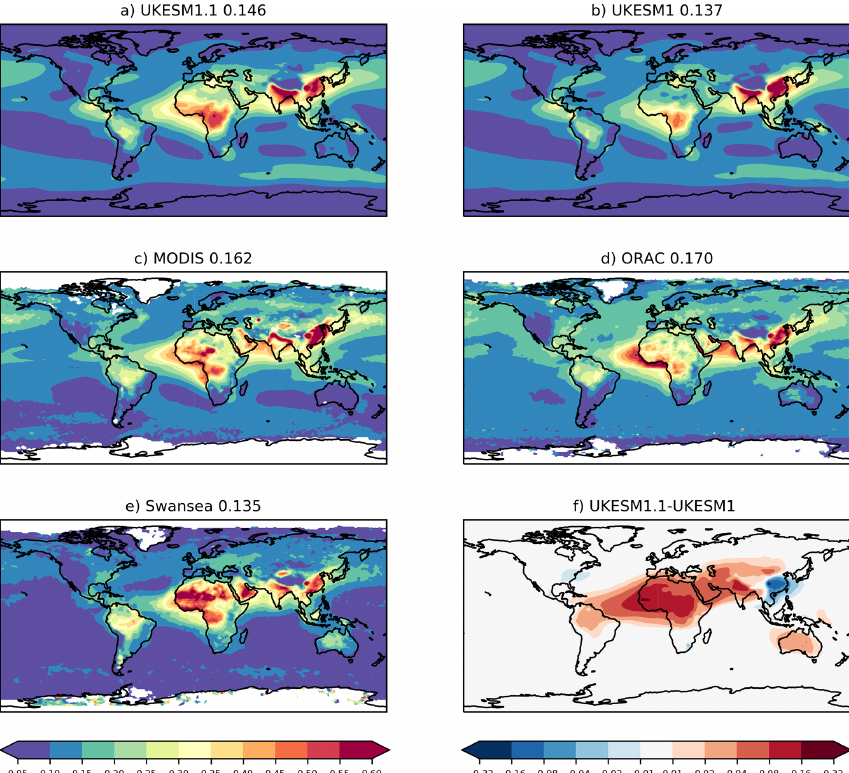
Figure 8. Annual mean AOD at 550nm from (a) UKESM1.1. (b) UKESM1 simulations over the 2003–2014 period. Satellite-derived AOD over the same period from (c) MODIS c6 (Hsu et al., 2004), (d) ORAC (Optimal Retrieval of Aerosol and Cloud; Thomas et al., 2009) and (e) Swansea retrieval algorithms (Bevan et al., 2012). (f) UKESM1.1 − UKESM1 AOD difference. The global mean AOD from models and satellites are shown in the panel